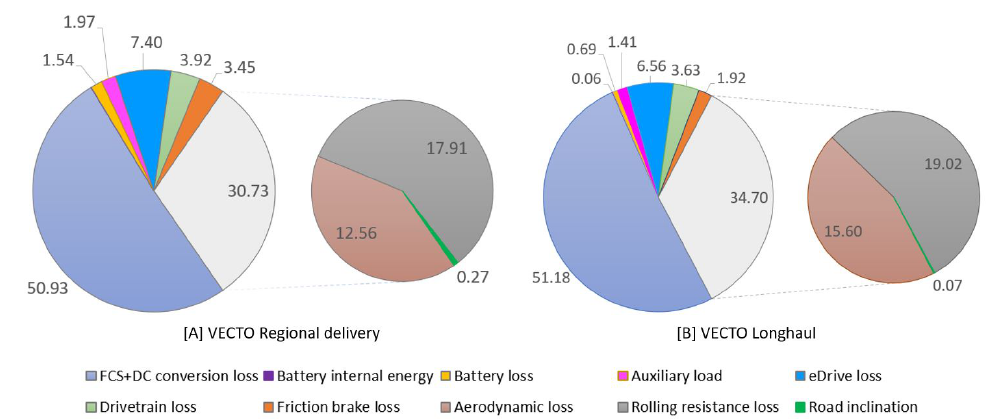
Figure 4. Percentage distribution of H 2 fuel energy expenditures and losses among different power- train subsystems and driving resistances for 40-tonne fuel cell truck running on ( A ) VECTO Regional Delivery and ( B ) Longhaul drive cycles.